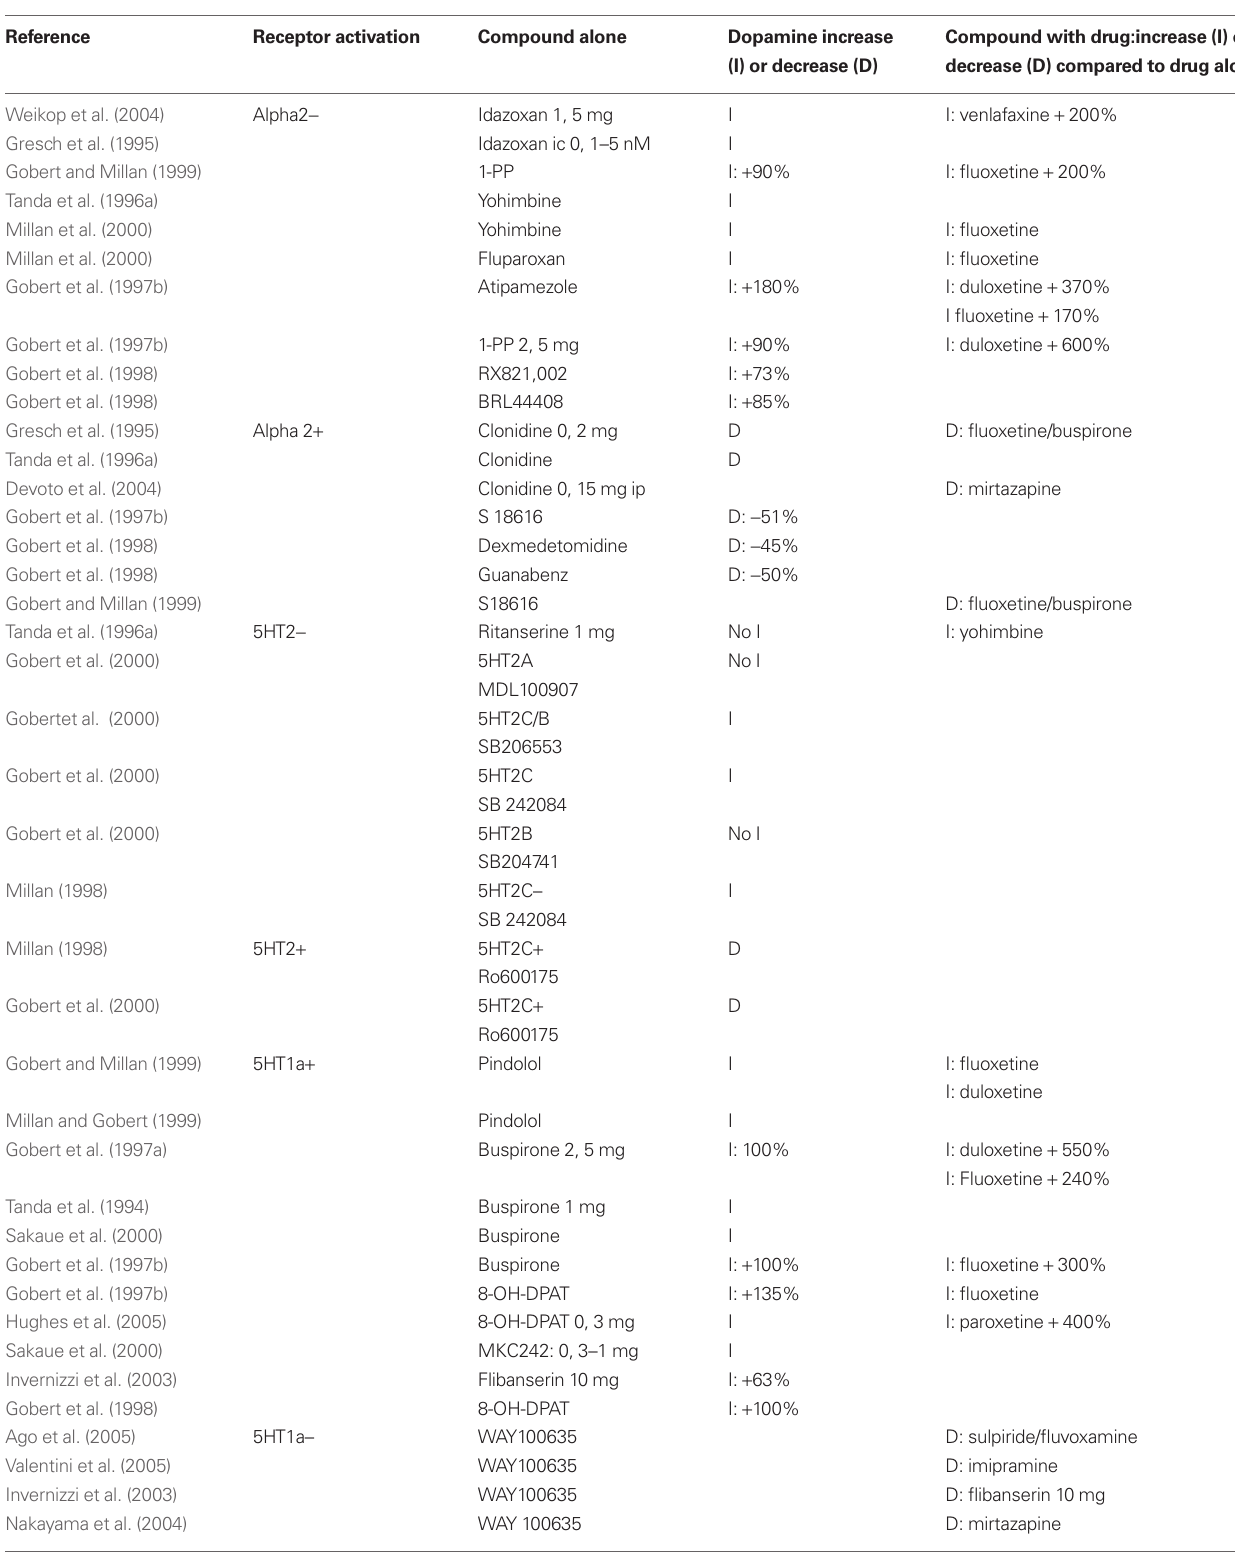
Table 2 | Prefrontal dopamine release from